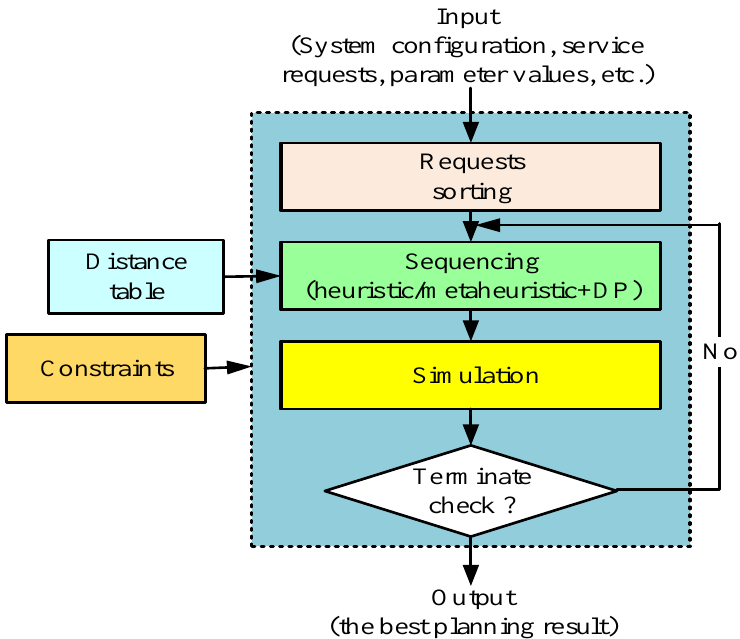
Figure 5. The simulation-based optimization framework. The framework can be transformed into a workflow diagram with input and output data flows represented as dotted red arrow lines, as shown in Figure 6. For example, the Simulation module inputs distance data of each dual command into the Energy calculation modulem which calculates and returns the energy cost of dual commands.